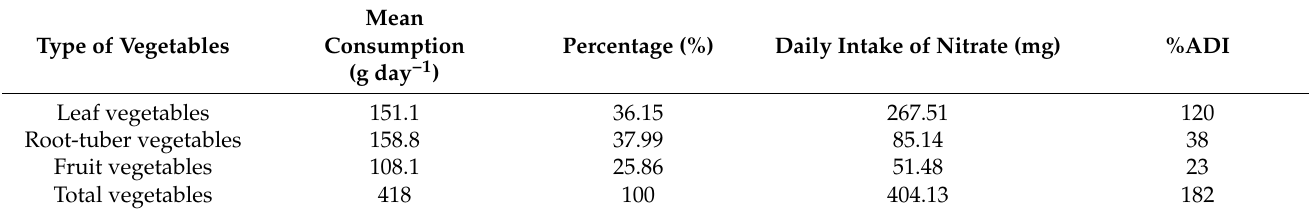
Table 5. Consumption pattern of vegetables in